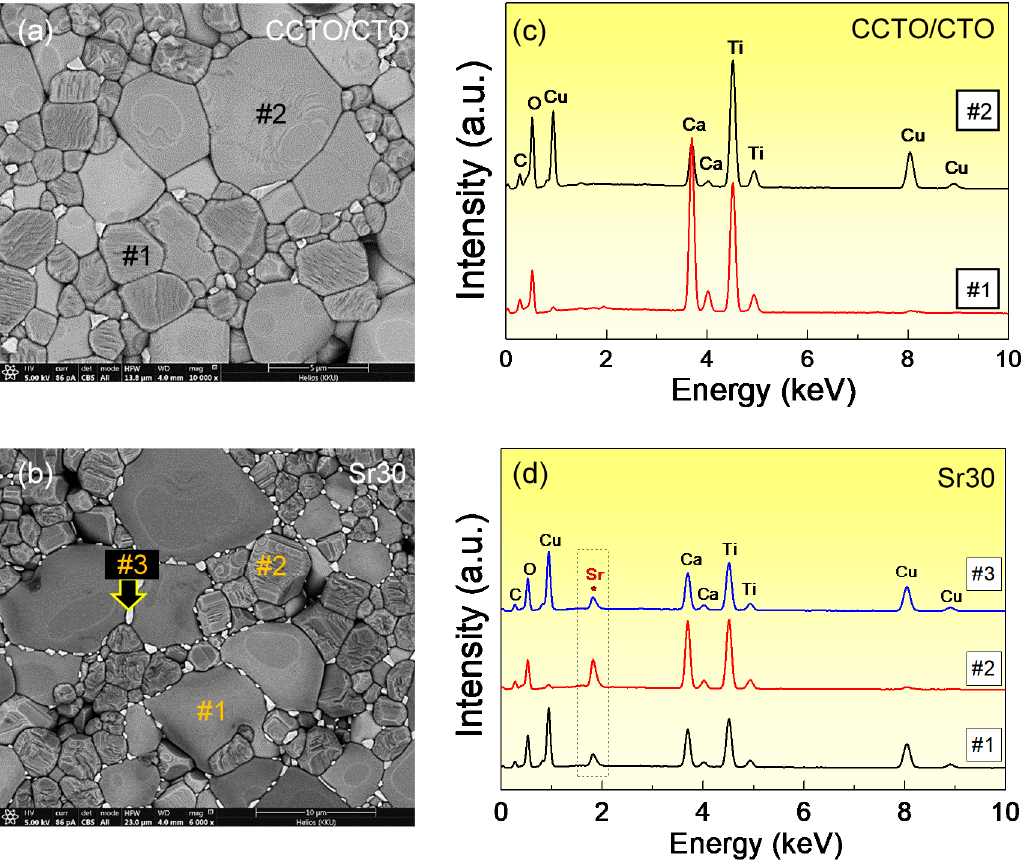
Figure 3. Backscattered SEM images of polished Sr2+-doped CCTO/CTO composite samples: ( a ) CCTO/CTO and ( b ) Sr03 composite samples. Energy-dispersive X-ray spectrometry (EDS) of ( c ) CCTO/CTO and ( d ) Sr30 composite samples detected at different points on the surface in the backscattered SEM image